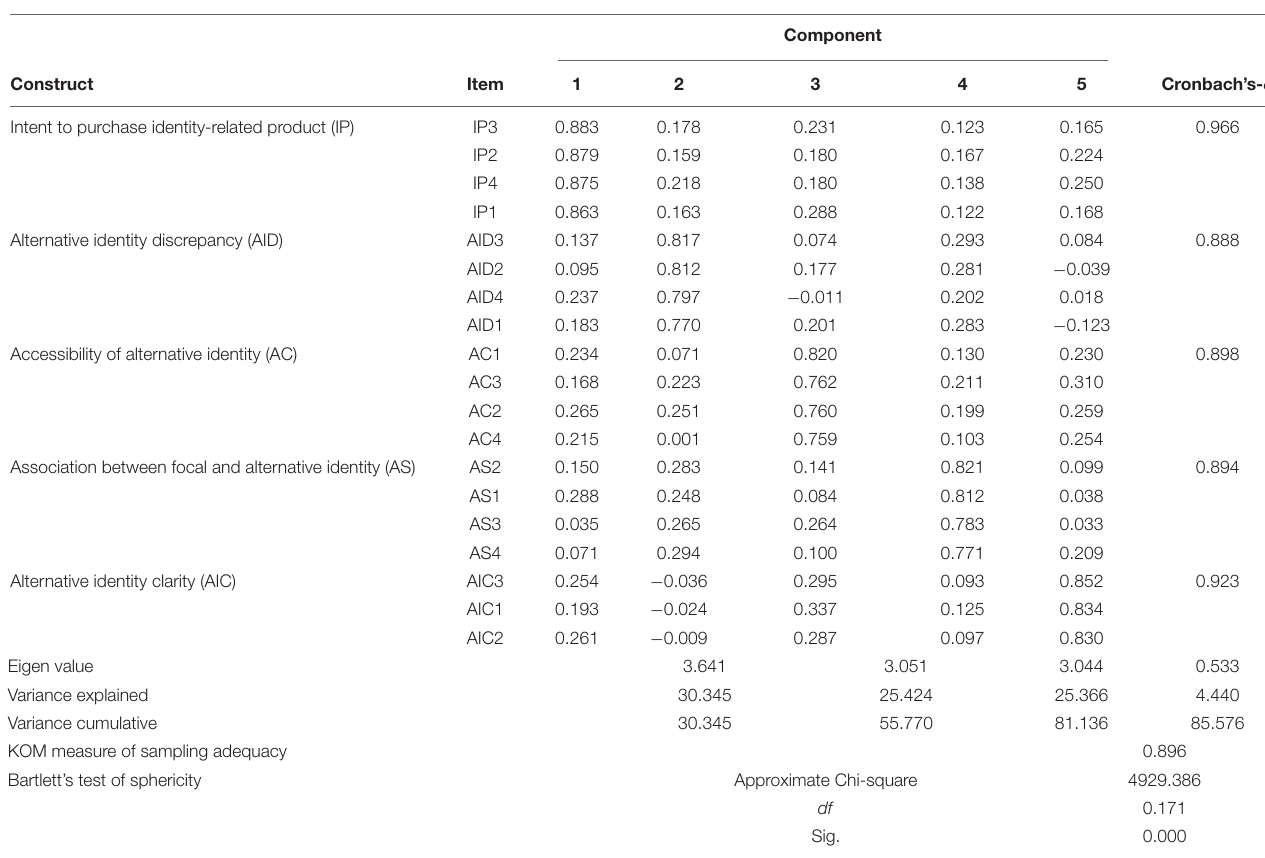
TABLE 2 | The reliability and validity results of the principal